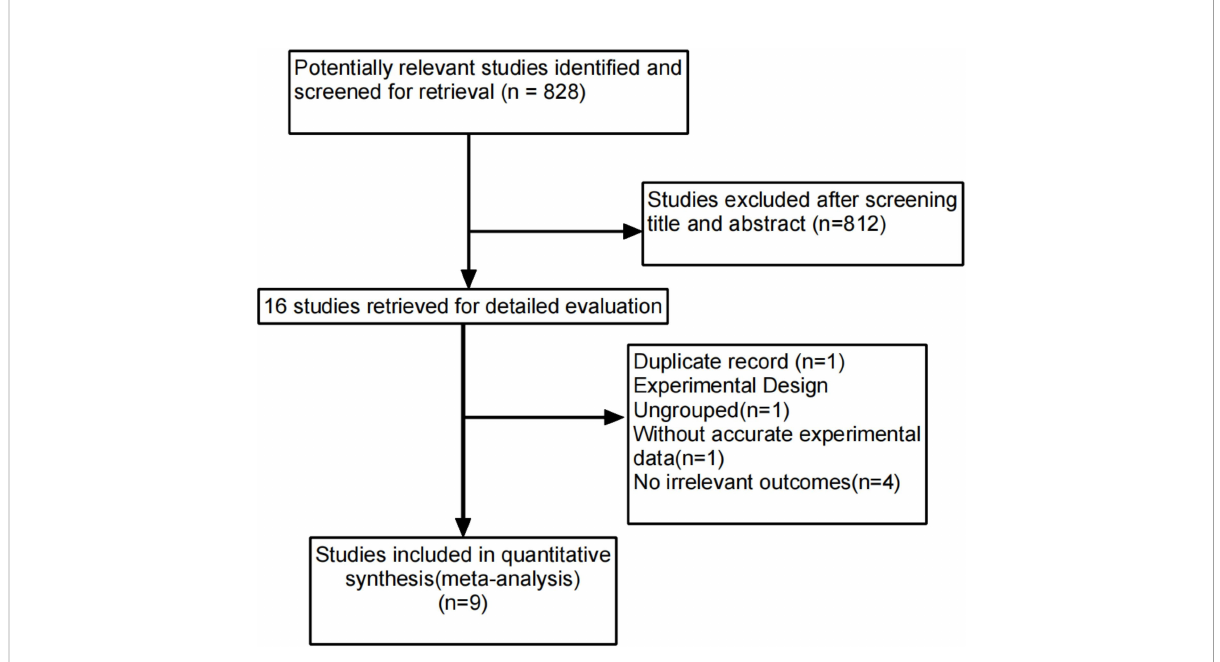
FIGURE 2 Process for identifying studies eligible for the meta-analysis.